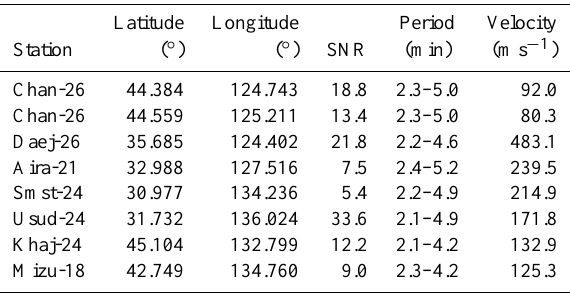
Table 2. Same as Table 1 but for the low-frequency